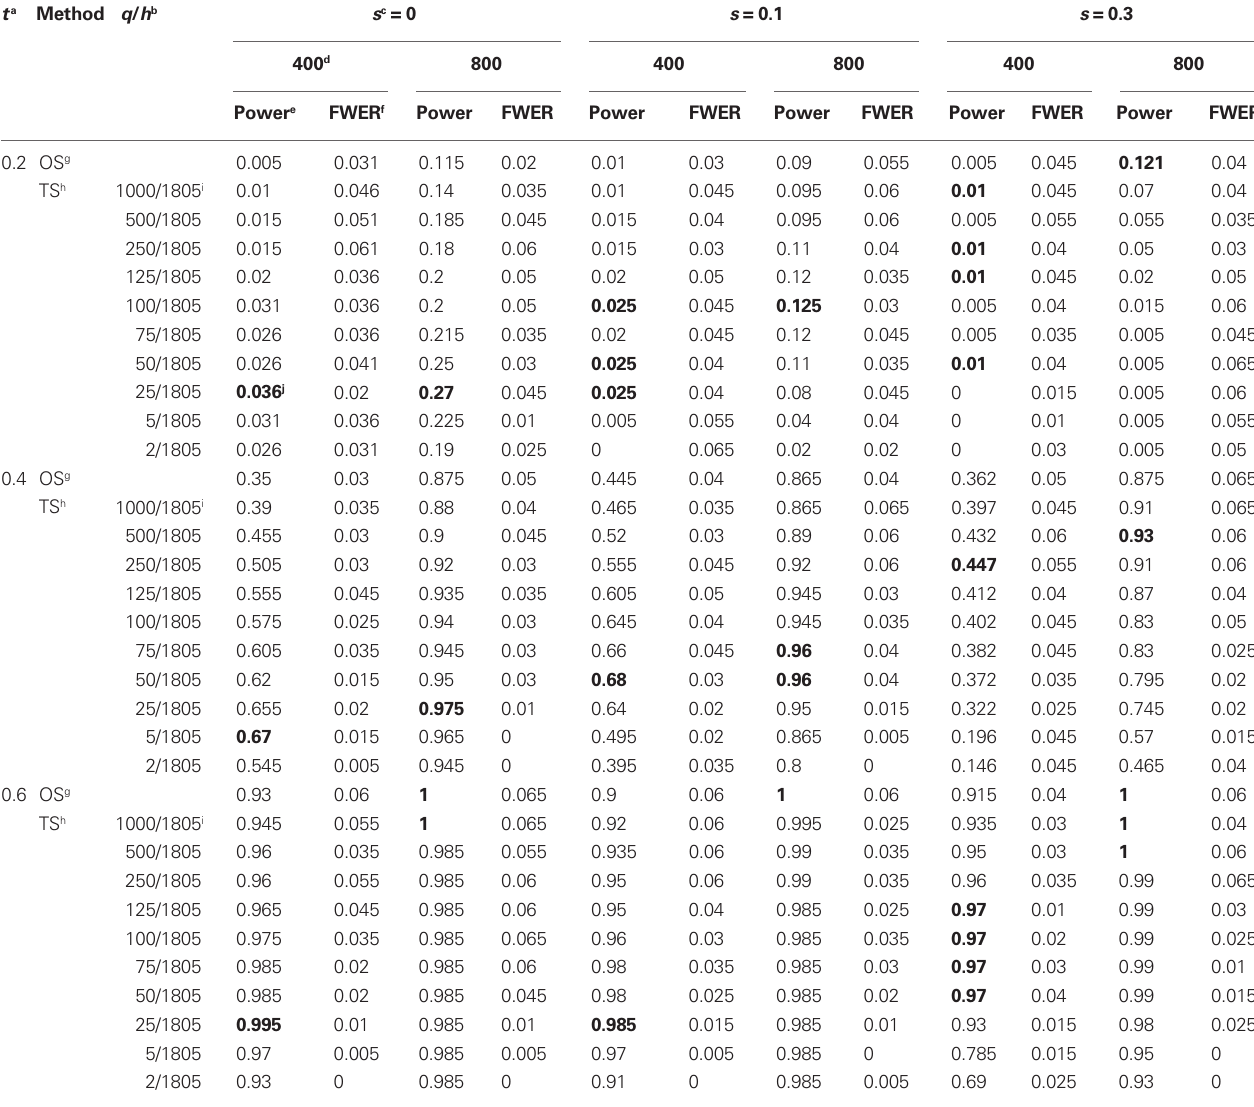
Table A4 | empirical power and FWer of the two-stage procedure at a significance level of 0.05 (200 replicates). t a method q / h